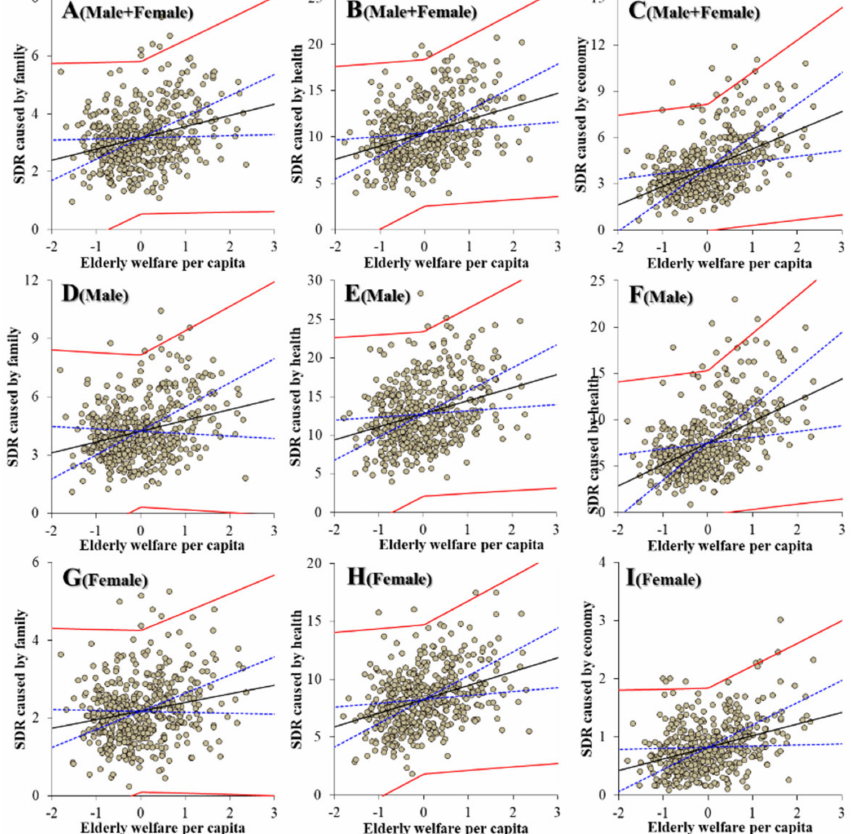
Figure 5. Relationship between financial expenditure per capita of elderly welfare of prefectures and municipalities, and suicide mortalities of males + females ( A – C ), males ( D – F ) and females ( G – I ) caused by motives associated with family ( A , D , G ), health ( B , E , H ) and economy ( C , F , I ), and suicide mortality of both genders (males + females) caused by family ( A , D , G ), health ( B , E , H ) and economy ( C , F , I ) from 2009 to 2018 by fixed- or random-effect analysis of hierarchal linear regression with robust standard error. Ordinates and abscissas indicate SDR of suicide mortalities (per 100,000 population) and centralised (by average) social welfare expenditure per capita of prefectures plus municipalities (JPY 10,000), respectively. Black, blue and red lines are the slope of fixed effects, standard deviation of fixed effects and fixed effects with random effects,